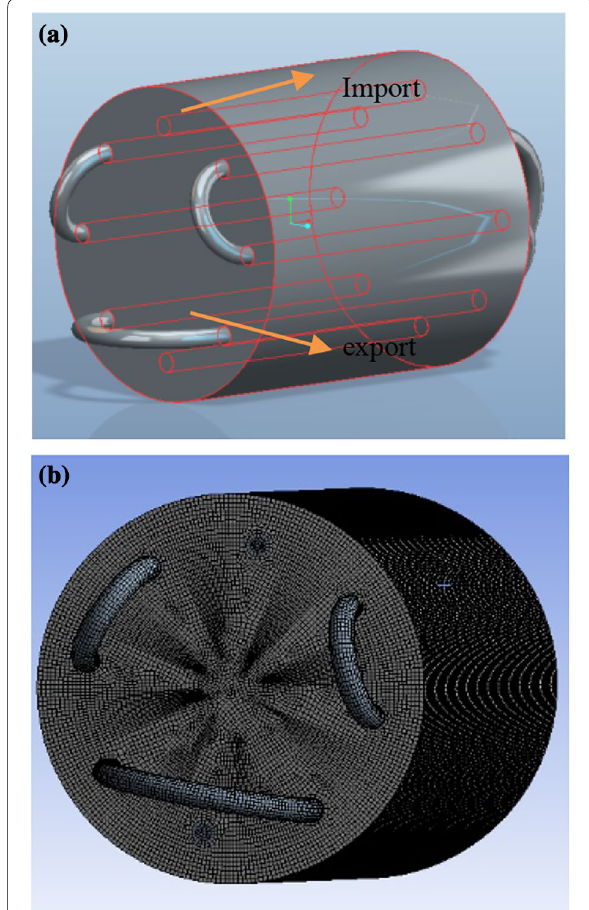
Figure 6 Three‑dimensional model diagram of the work roll